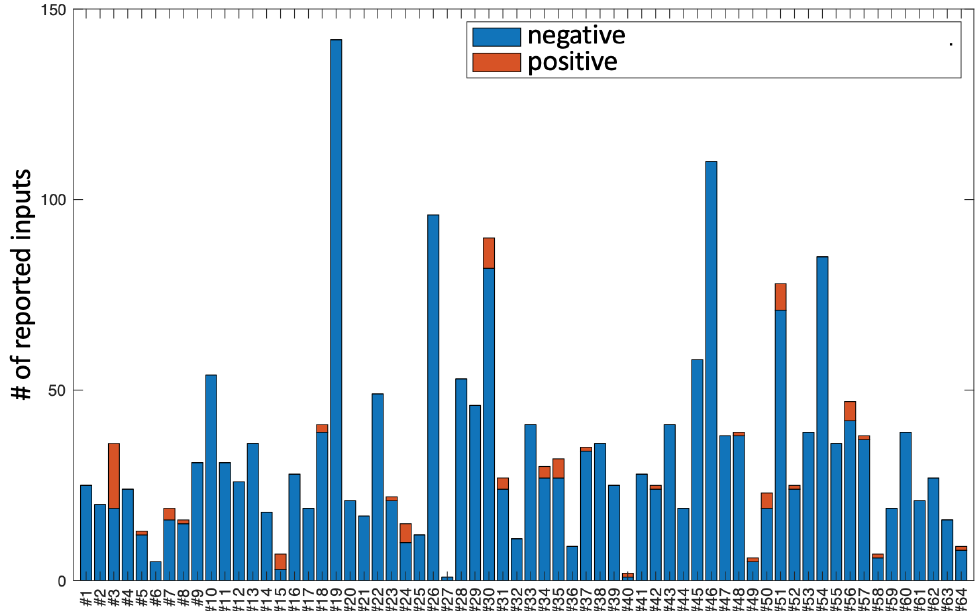
Figure 2. Representation of the number of interactions that each subject in the study had with his/her application. The proportion of these messages that were not directly linked to any self-harm is shown in blue, and that which was directly linked to self-harm in red. Note that of the 64 subjects present, 24 reported one or more